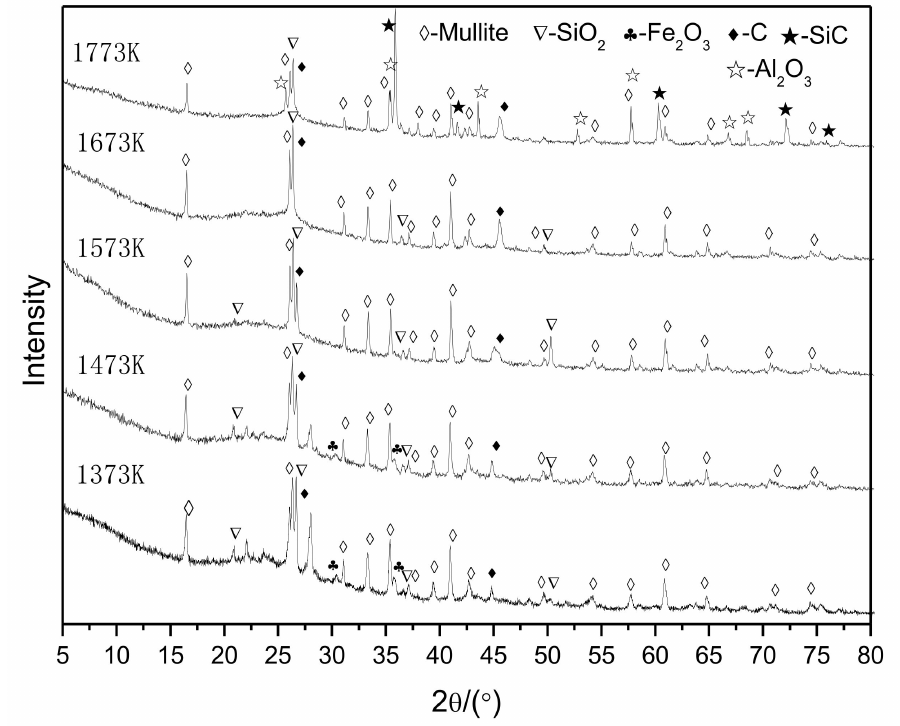
Figure 5. XRD patterns of residues at 1373 K~1773